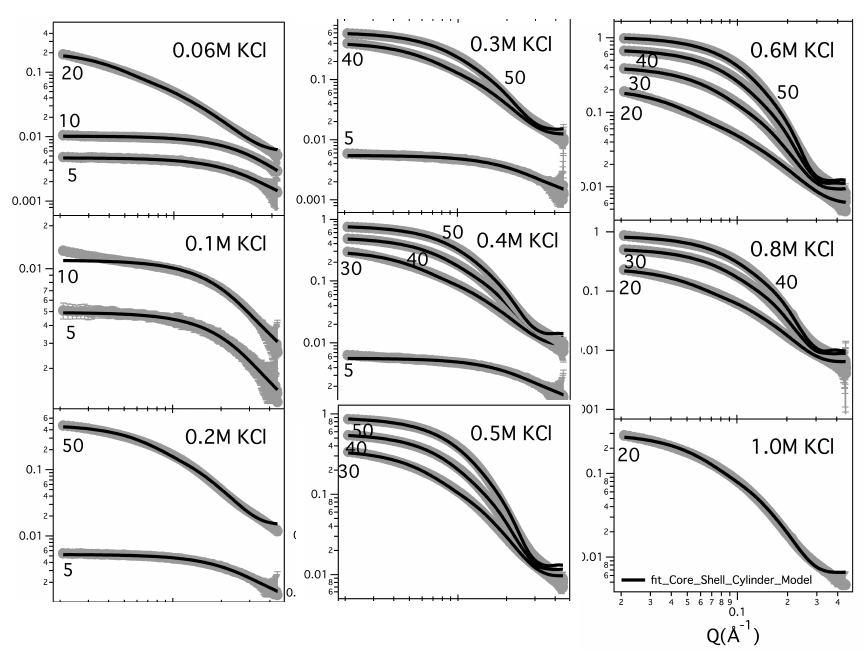
Figure 9. Experimental and model fitting SAXS curves for GMPNa 2 samples prepared in KCl solution. Common fitting parameters were: R core = 1.8 ± 0.2 Å, δ = 11.2 ± 0.4 Å, ρ core = ( 0.57 ± 0.01 ) e/Å 3 and ρ shell =(0.46 ± 0.02) e/Å 3 . In each frame, GMPNa 2 (in mg/mL) and KCl (in M)